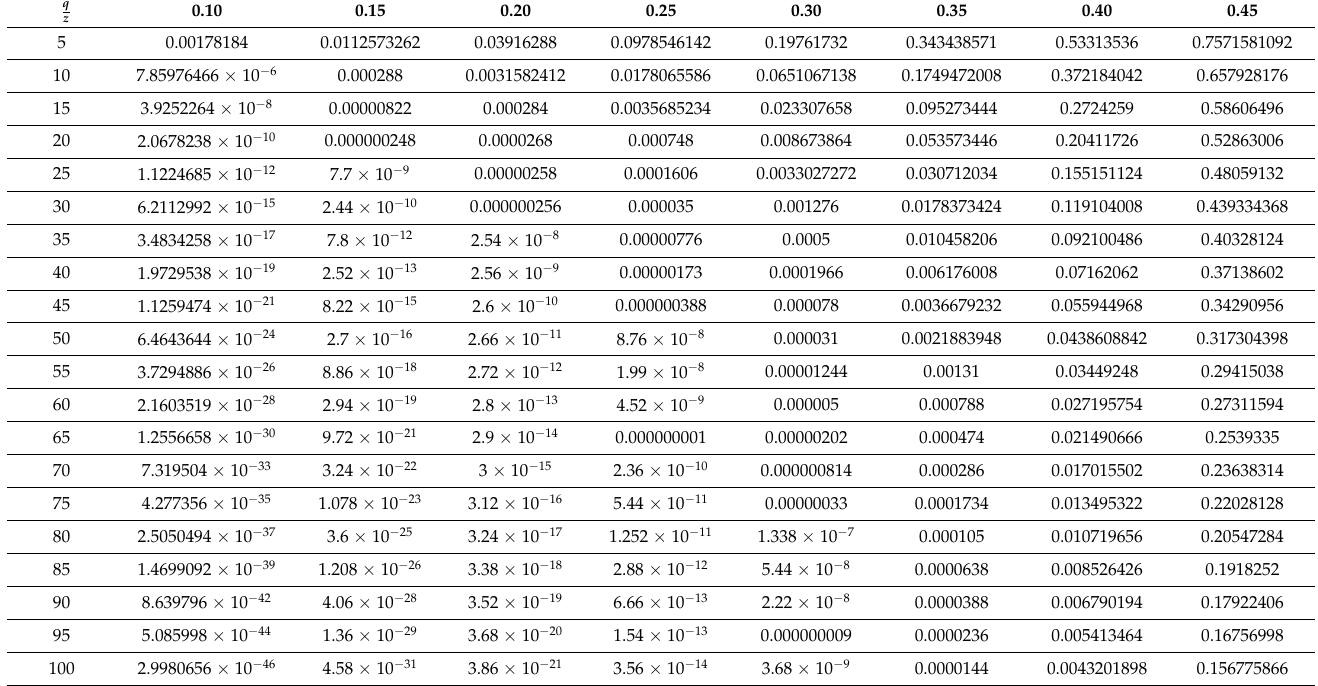
Table 1. Double-spend attack probability P ( A ( z )) = 2 I q ( z , z ) .